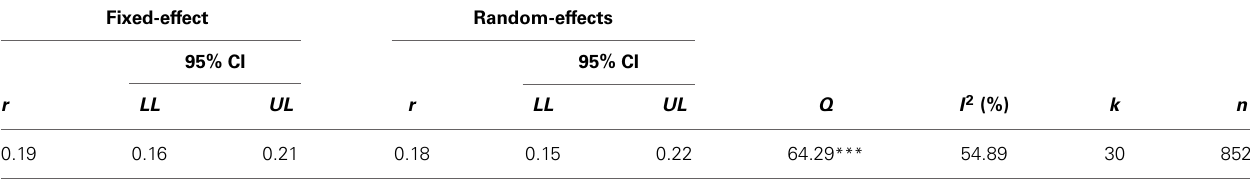
Table 4 | Meta-analysis